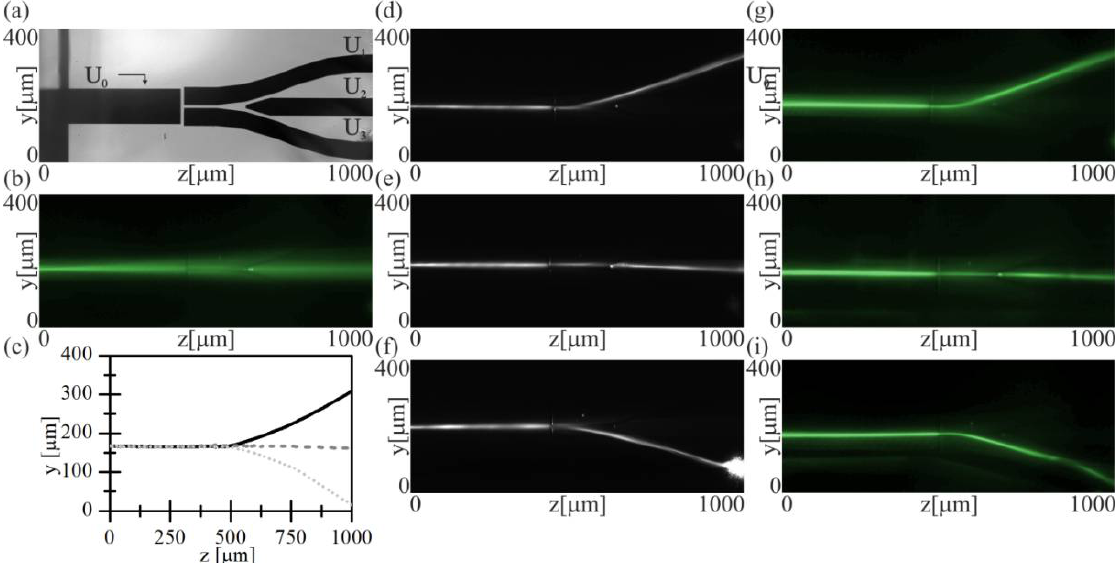
Figure 9. Combination of four independent controlled electrodes of a 100 µ m width in the initial channel and 50 µ m in the output channels formed an optical 1 × 3-junction for TM-polarized beam: ( a ) Electrodes within NLC cell. ( b ) Propagation of low-power signal beam ( λ = 532 nm, TM- polarization). ( c ) Trajectories of self-induced nonlinear waveguides obtained for IR beam of optical power P = 1.6 mW, TM-polarization, U 0 = 1.7 V. ( d – f ) Nematicon propagation for driving voltage applied sequentially to the electrodes U 1 = 1.7 V, U 2 = 1.7 V and U 3 = 1.7 V. ( g – i ) Guided low-power signal beam ( λ = 532 nm, TM- polarization) co-coupled collinearly with an infrared beam.